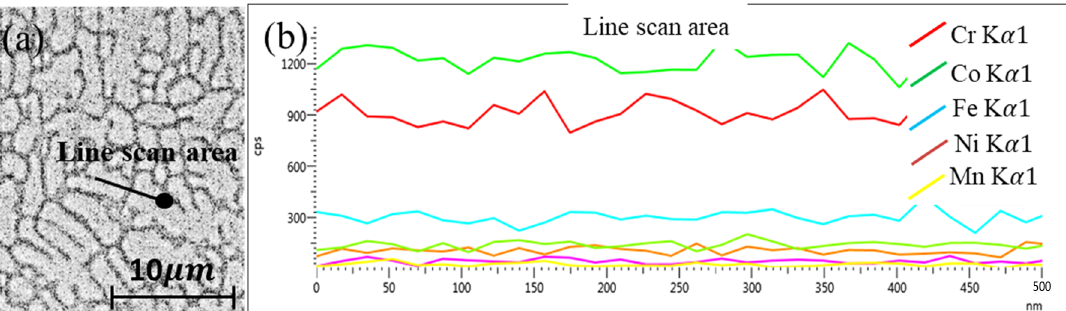
Figure 5. EDS line scan area ( a ) and element distribution ( b ) of Sn 0 alloy coating.